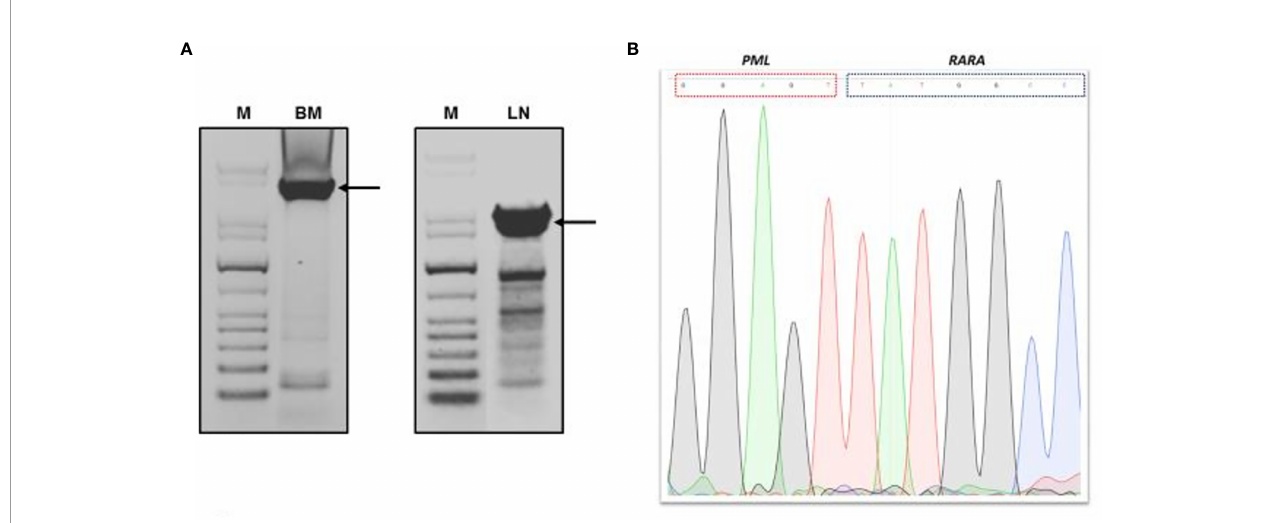
FIGURE 2 | Genomic PML/RARA breakpoint analysis by long-range nested PCR. (A) Agarose gel electrophoresis of long-range PCR products from bone marrow and lymph node section DNA analysis. (B) Sanger sequencing result of long-range PCR product of PML/RARA genomic ampli fi cation derived from BM analysis. Sequence was aligned to the intronic sequences of PML and RARa genes. M, GenLadder 1kb DNA Ladder; BM, bone marrow; LN, lymph node. Arrows indicated the long-range PCR products puri fi ed from